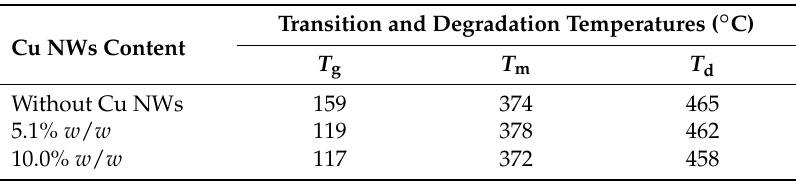
Figure 10. Thermal analysis of the substrates without Cu NWs ( ◦ ), with 5.1% w / w ( ∗ ), and with 10.0% w / w ( (cid:3) ) Cu NWs. Representative curves ( a ) DSC, ( b ) TGA and ( c ) DTGA as a function of temperature. Table 6. Values determined from DSC and TGA analysis.